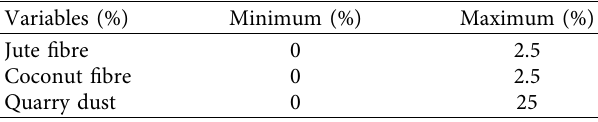
Table 1: Levels of